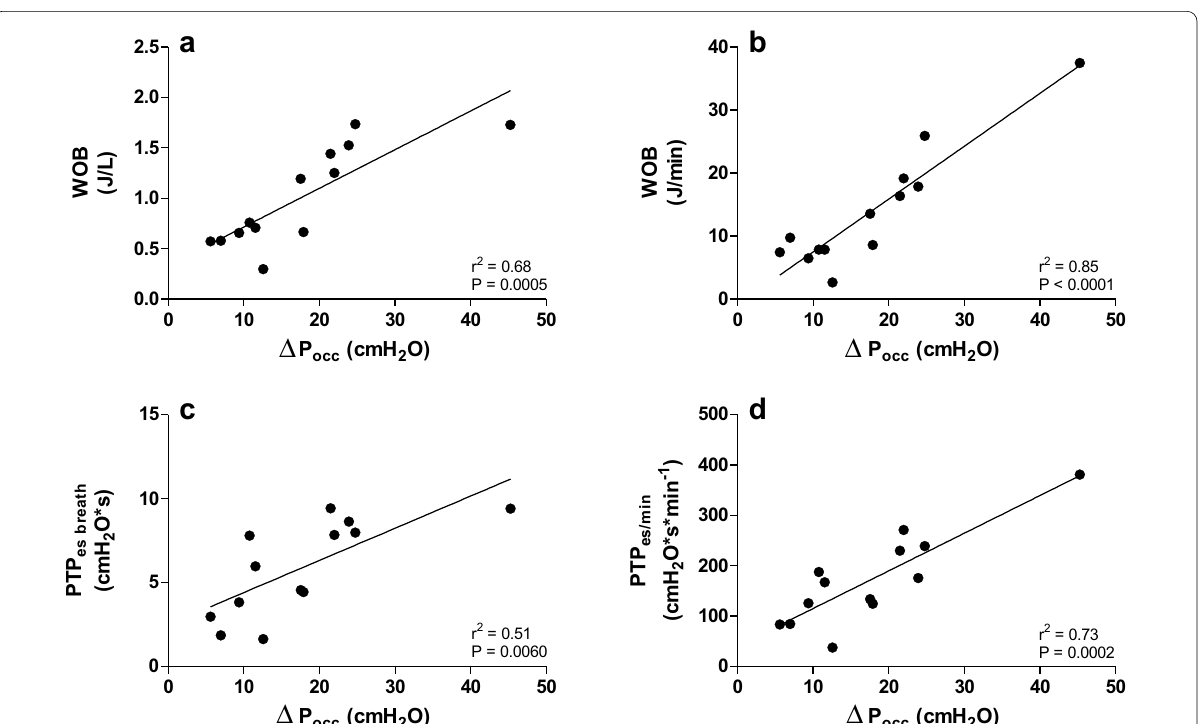
Fig. 4 Relation between occlusion pressure (∆ P occ ) and respiratory effort. ∆ P occ is moderately correlated with work of breathing (WOB) calculated per liter ( a ) and pressure time product of esophageal pressure per breath (PTP es breath ) ( c ). Higher correlations were found between ∆ P occ and respiratory effort when respiratory effort was calculated per minute ( b , d